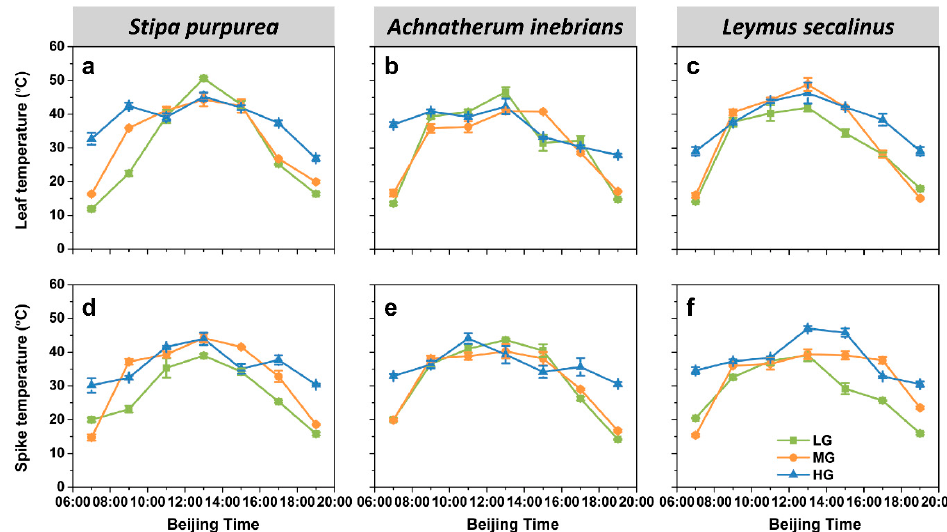
Figure 7. Diurnal dynamics of the leaf temperature (T l ) and spike temperature (T s ) of S. purpurea ( a , d ), A. inebrians ( b , e ) and L. secalinus ( c , f ) in response to grazing intensity (LG, light grazing; MG, medium grazing; HG, heavy grazing). The data are presented as mean ± standard error (SE) of three independent experiments.